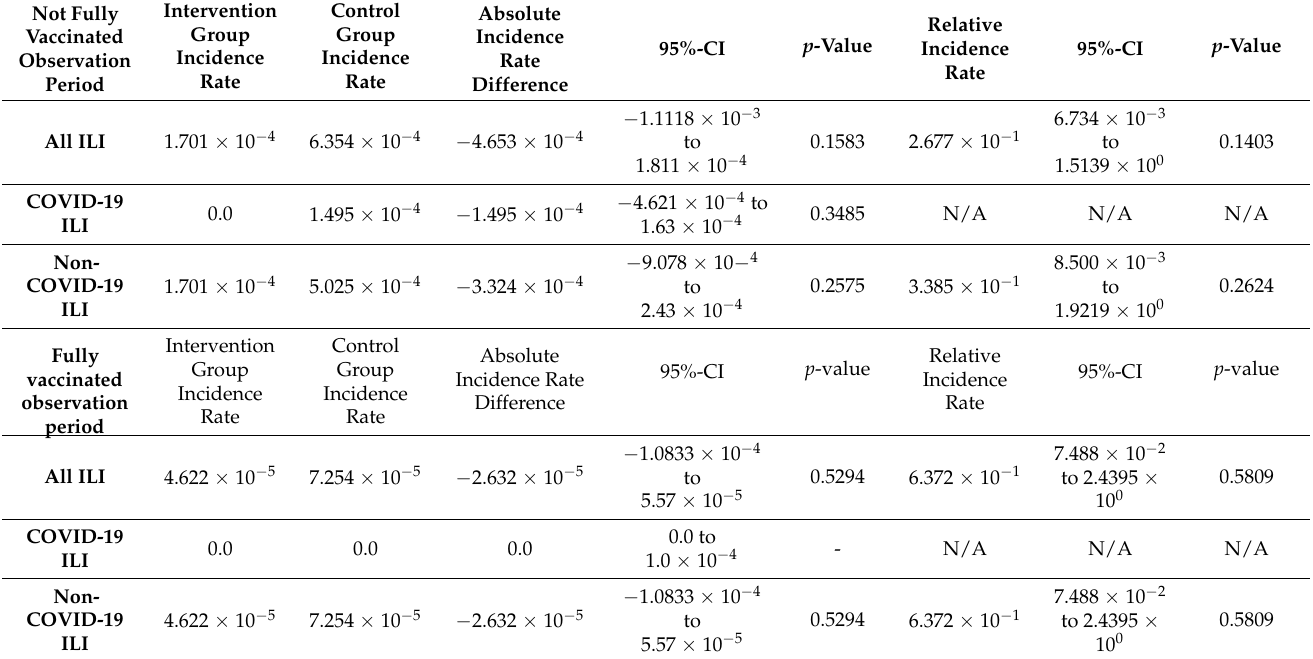
Table 4. Outcomes by vaccination status observation period.